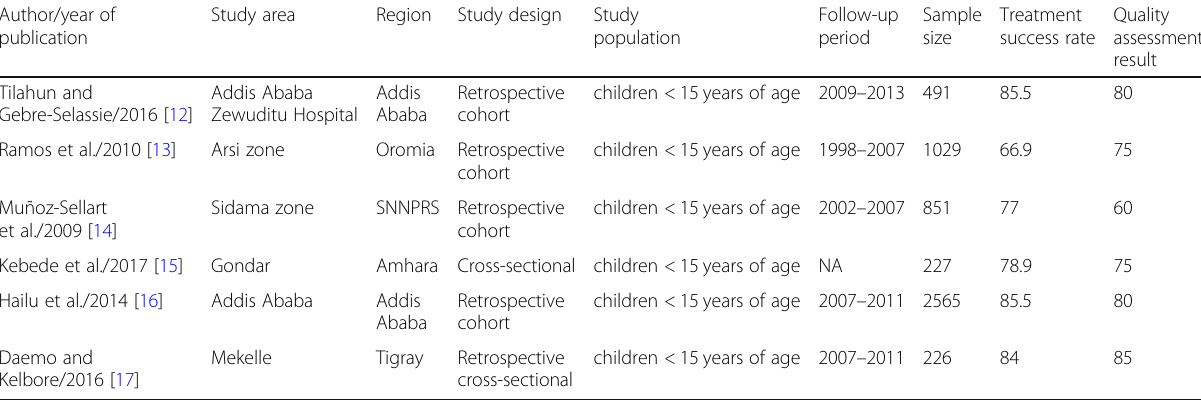
Table 1 General characteristics of included studies